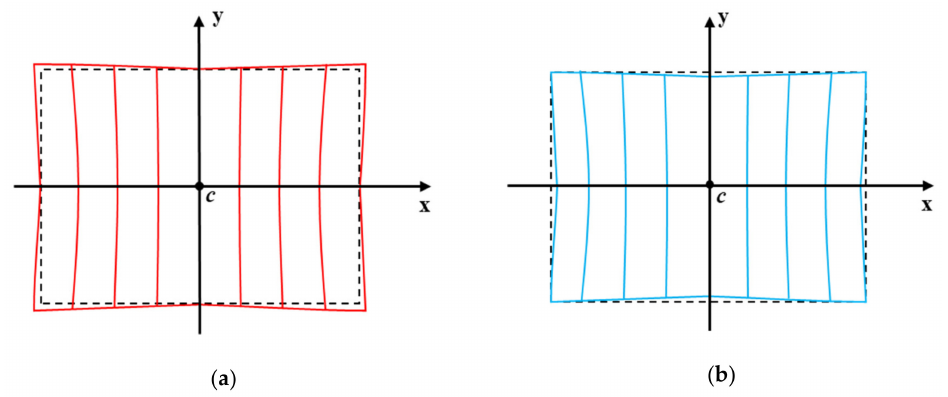
Figure 1. Type of pincushion distortion. ( a ) Negative pincushion distortion, ( b ) positive pincushion